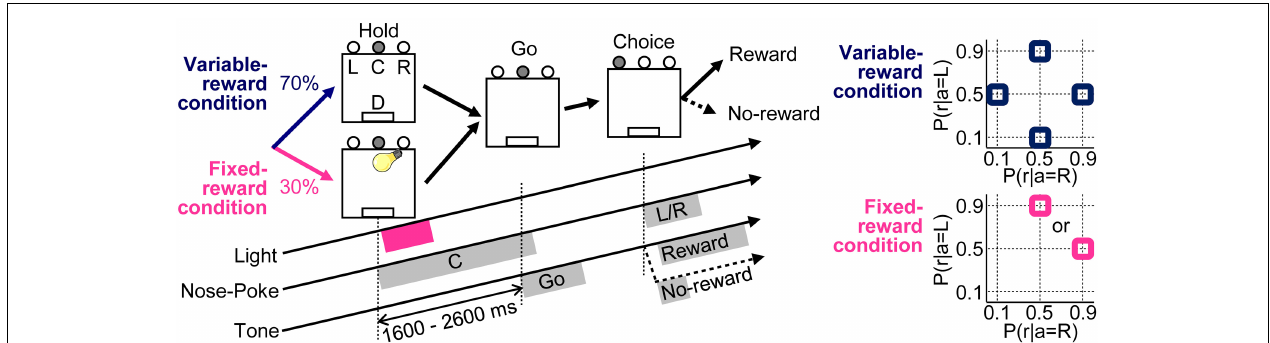
FIGURE 1 | Free choice task. Variable- and fixed-reward conditions were randomly assigned for each trial in a 70% / 30% ratio, respectively. In both conditions, each trial was initiated when a rat poked its nose into the center hole (C), after it had to keep poking for 1600–2600ms until a “go” tone sounded (Hold). During the fixed-reward condition only, a short light stimulus was presented during the center-hole poking to inform rats that the trial was a fixed-reward-condition trial. After the presentation of “go” tone (Go), rats